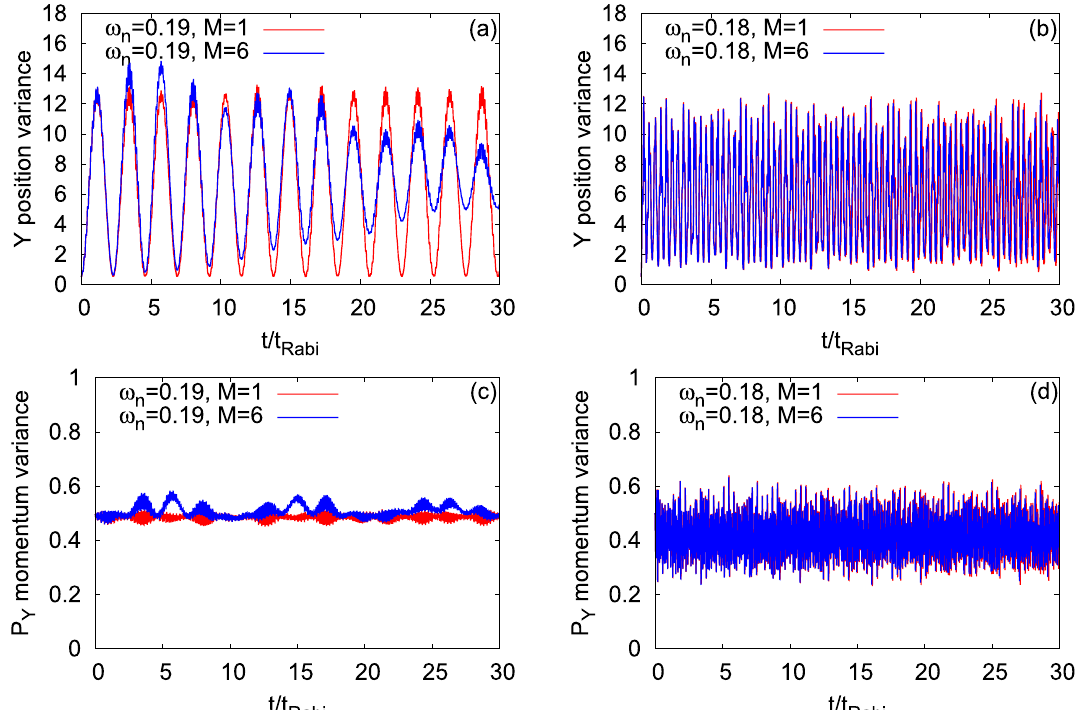
0.19 ) and (cid:31) X (right column, = 10 and the =